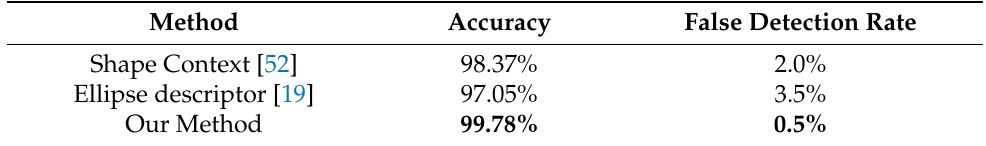
Table 9. Postures classification accuracy comparison of different features- extraction methods using Dataset